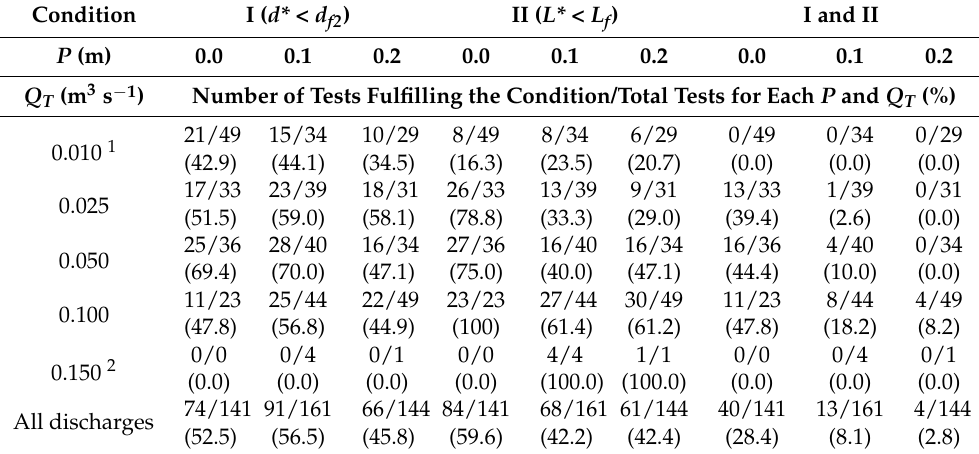
Table 2. Number of tests that met the energy dissipation criteria for different basin dimension conditions for different values of P .